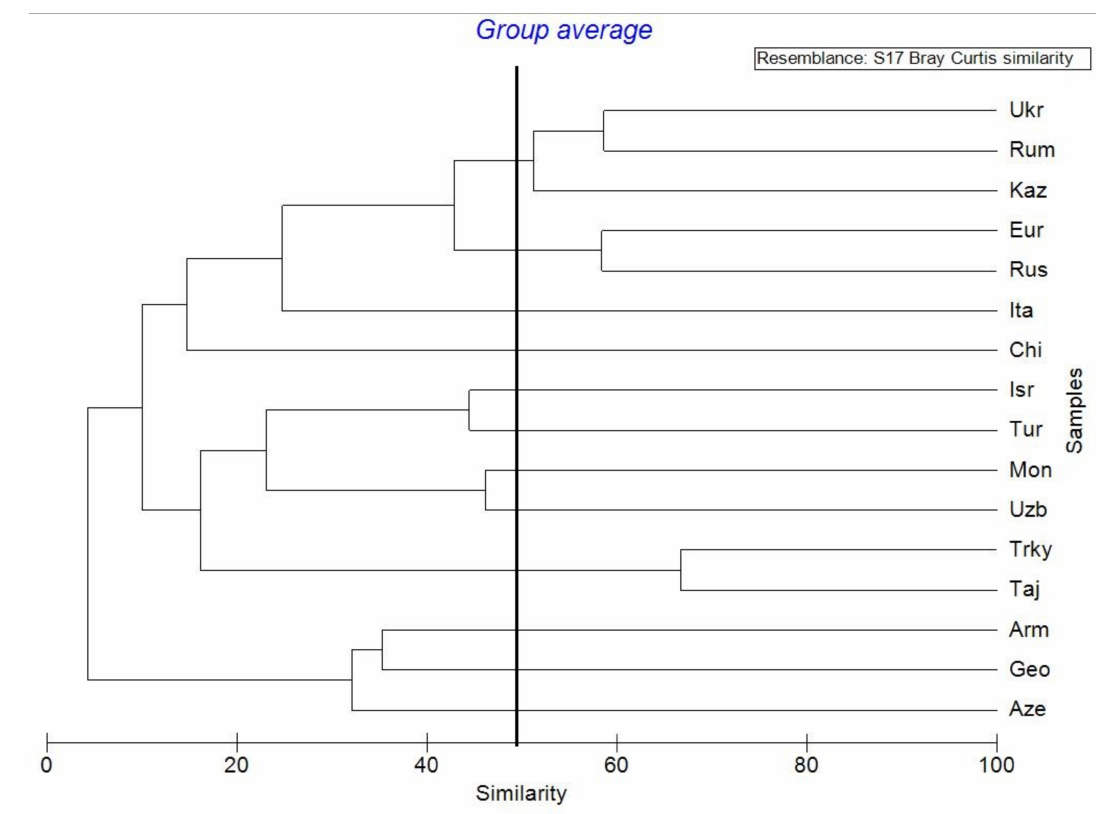
Figure 2. Dendrogram of the similarity of the species composition of Calanoida in countries with different climatic conditions. Abbreviations: Isr—Israel, Tur—Turkmenistan, Mon—Mongolia, Uzb—Uzbekistan, Taj—Tajikistan, Rus—Russia, Kaz— Kazakhstan, Chi—China, Arm—Armenia, Geo—Georgia, Aze—Azerbaijan, Trky—Turkey, Ita—Italia, Eur—Europa (in total), Rum—Romania,